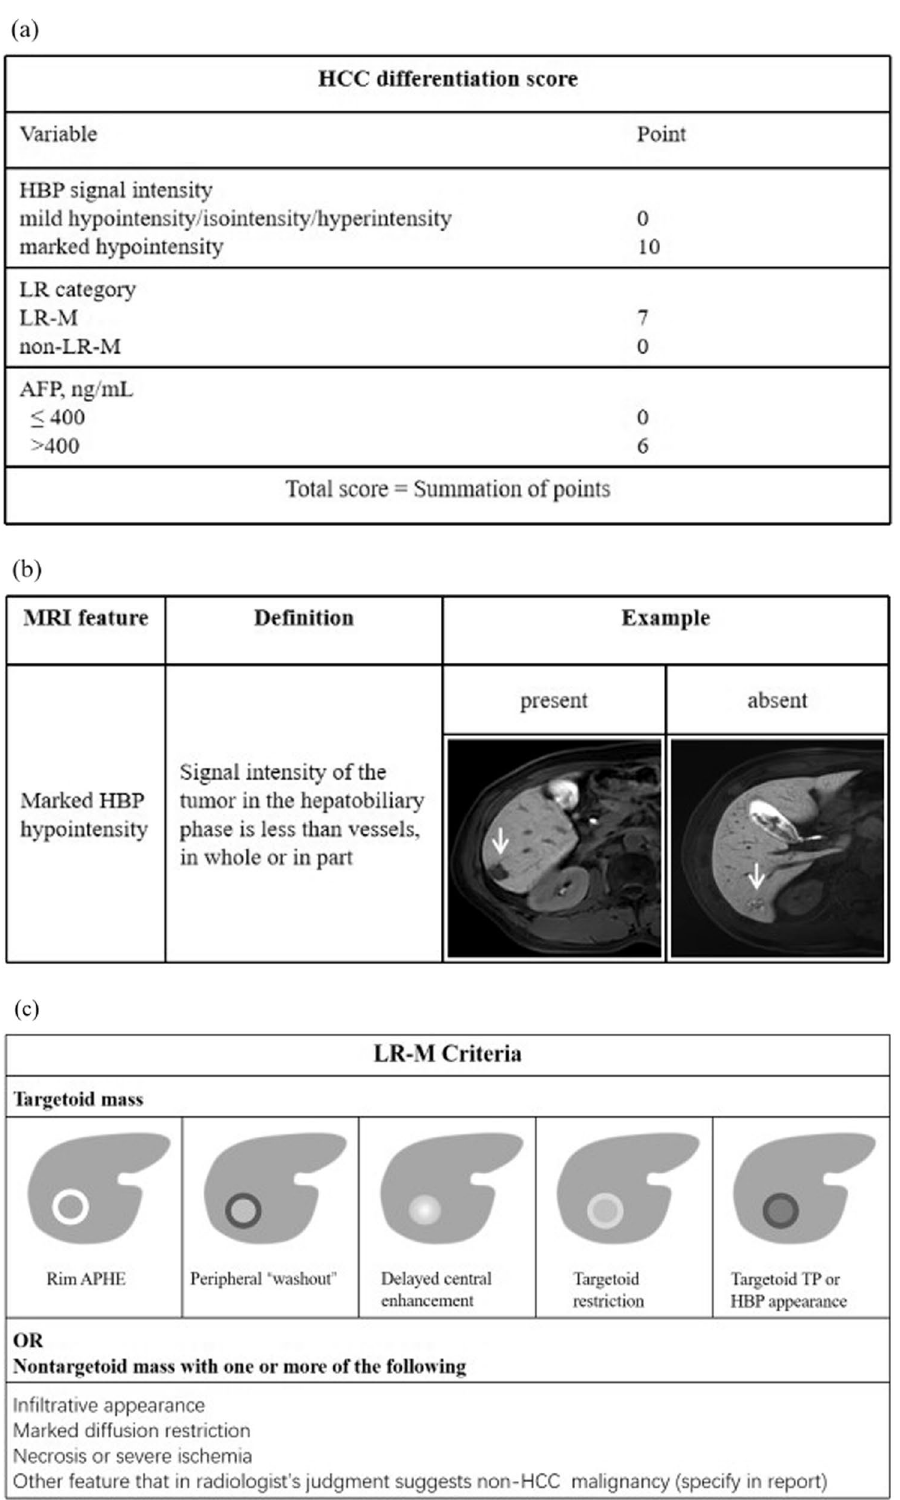
Fig. 2 a Illustration of the HCC differentiation score; b definitions and representative images of the MRI feature associated with the HCC differentiation score; c illustration of LR-M criteria. HCC, hepatocellular carcinoma; AFP, serum alpha-fetoprotein; HBP, hepatobiliary phase; LR, Liver Imaging Reporting and Data